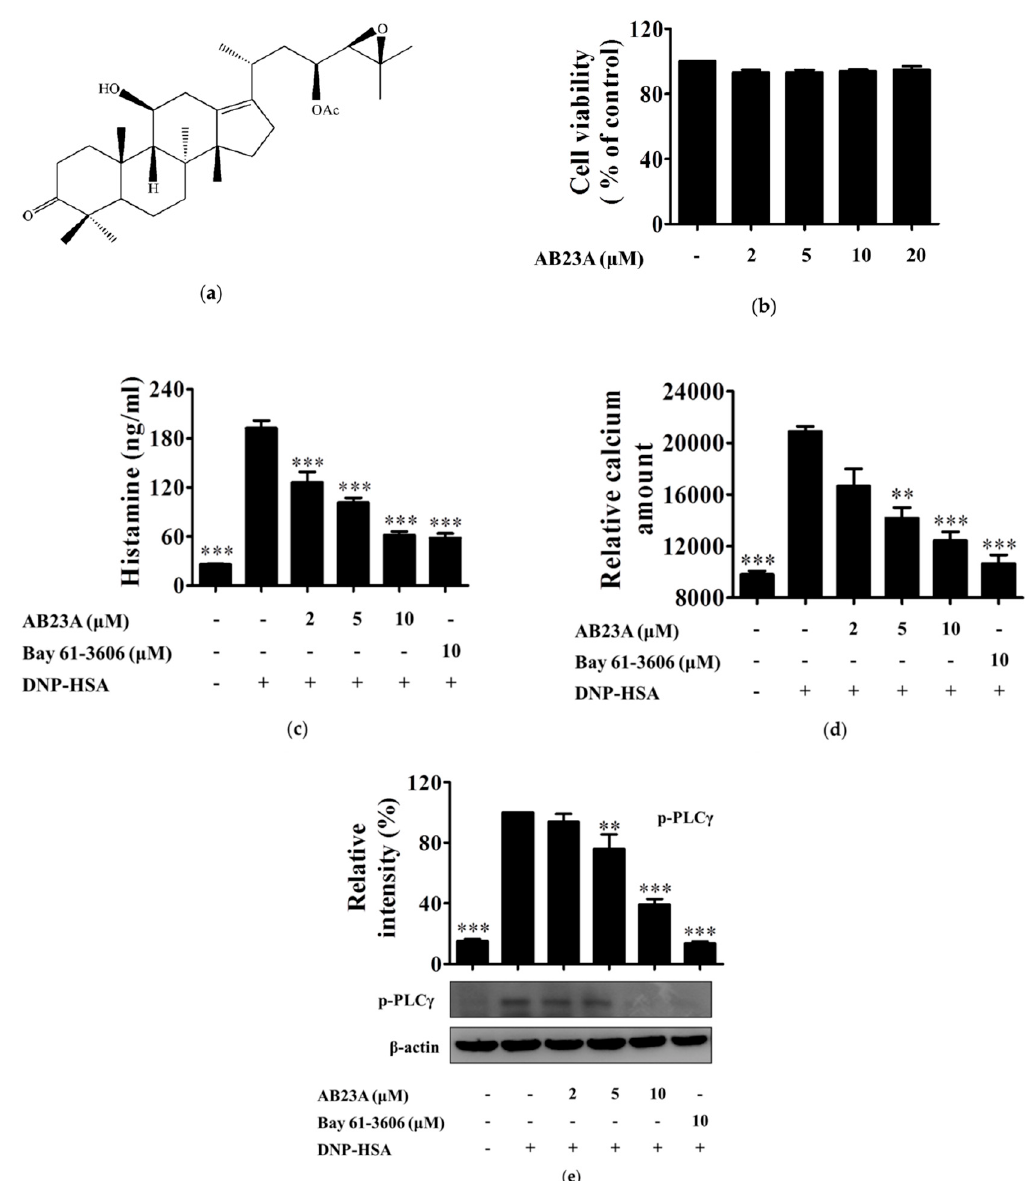
Figure 1. AB23A inhibits histamine release and Ca 2+ mobilization by phospholipase C γ (PLC γ ) phosphorylation in immunoglobulin E/antigen (IgE/Ag)-stimulated bone marrow-derived mast cells (BMMCs). ( a ) Chemical structure of AB23A; ( b ) incubation of BMMCs with various concentrations (2, 5, 10, and 20 µ M) of AB23A for 8 h. Cells cytotoxicity was determined by MTT assay; ( c ) IgE-sensitized BMMCs were pre-treated with AB23A or Bay 61-3606 for 1 h, and then stimulated with DNP-HSA for 15 min. The amount of histamine released into the culture media was measured by ELISA; ( d ) IgE-sensitized BMMCs were pre-incubated with FluoForte TM dye-loading solution for 1 h, and then treated with AB23A or Bay 61-3606 for 1 h. The fluorescence was measured after stimulation with DNP-HSA for 5 min; ( e ) IgE-sensitized BMMCs were stimulated with DNP-HSA for 15 min after being pre-treated with AB23A or Bay 61-3606 for 1 h. The cell lysates were collected and immunoblotted with antibody for phospho-PLC γ , the relative ratios of p-PLC γ was determined by analyzing immunoblot band intensities. The data show the mean ± SEM of three independent experiments. Analysis of variance (ANOVA), p < 0.0001, post hoc ** p < 0.01, and *** p < 0.001, compared with the BMMCs stimulated with IgE/Ag in the absence of AB23A. 2.2. AB23A Inhibits LTC 4 Generation via Blocking the Phosphorylation of p38 and ERK and Translocation of cPLA 2 into the Nuclear Envelope